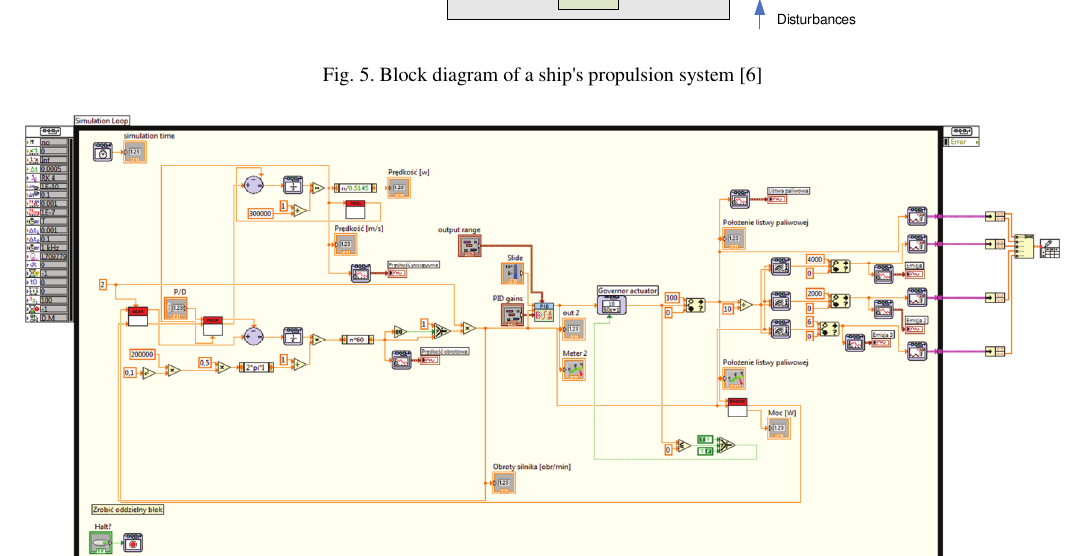
Fig. 6. Simulation model of a ship's propulsion in the Labview environment